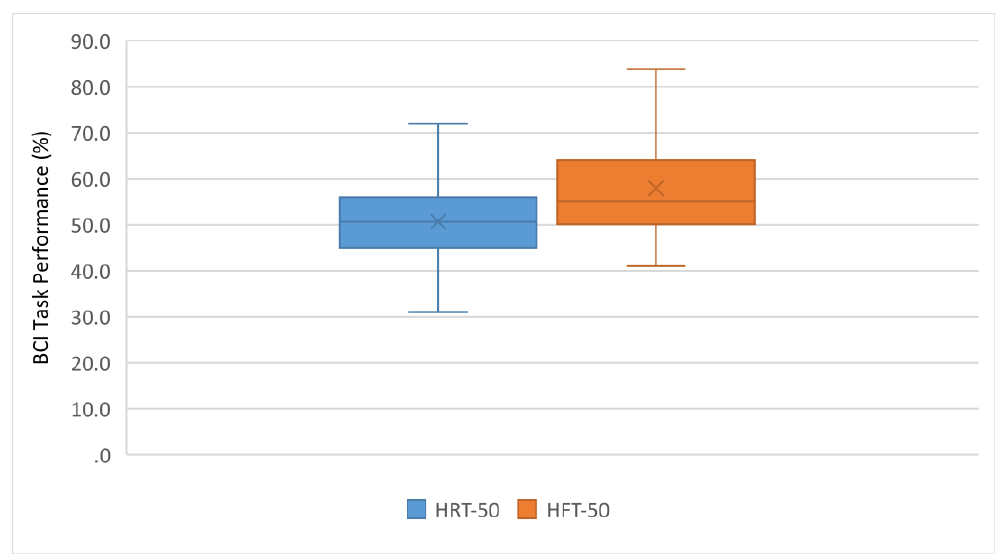
Figure 7. Task performance average in HRT vs. HFT.